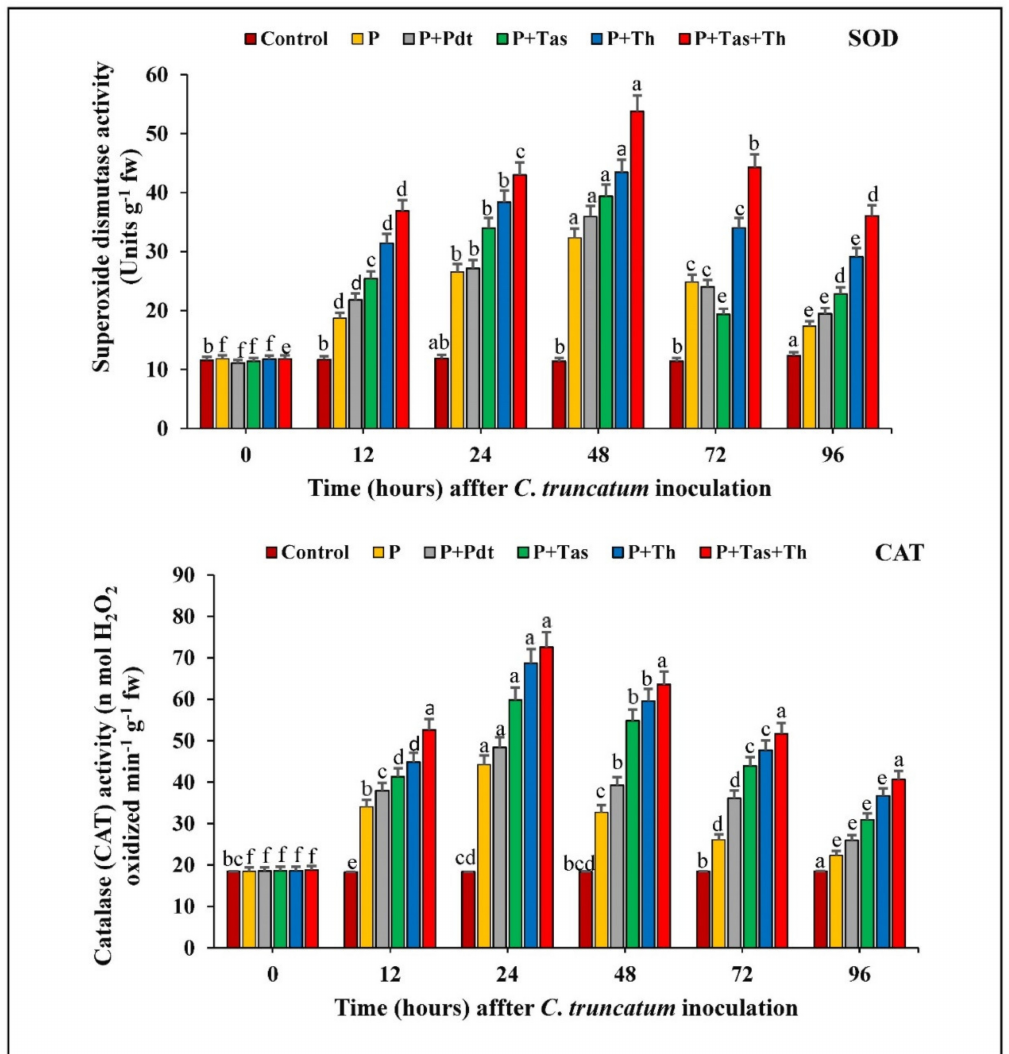
Figure 12. The effect of bioagents (Pdt = P. dendritiformis, Tas = T. asperellum, Th = T. harzianum, and Tas+Th = T. asperellum + T. harzianum ) on the accumulation of antioxidative enzymes (SOD and CAT) either individually or in the combination of treatment in chilli seeds under a challenged condition and C. truncatum -infected samples. Each value is expressed as the mean of triplicates, and the bars sharing the same alphabetical letters are not significantly different ( p ≤ 0.05) using Duncan’s multiple range test. The vertical bar designates the standard